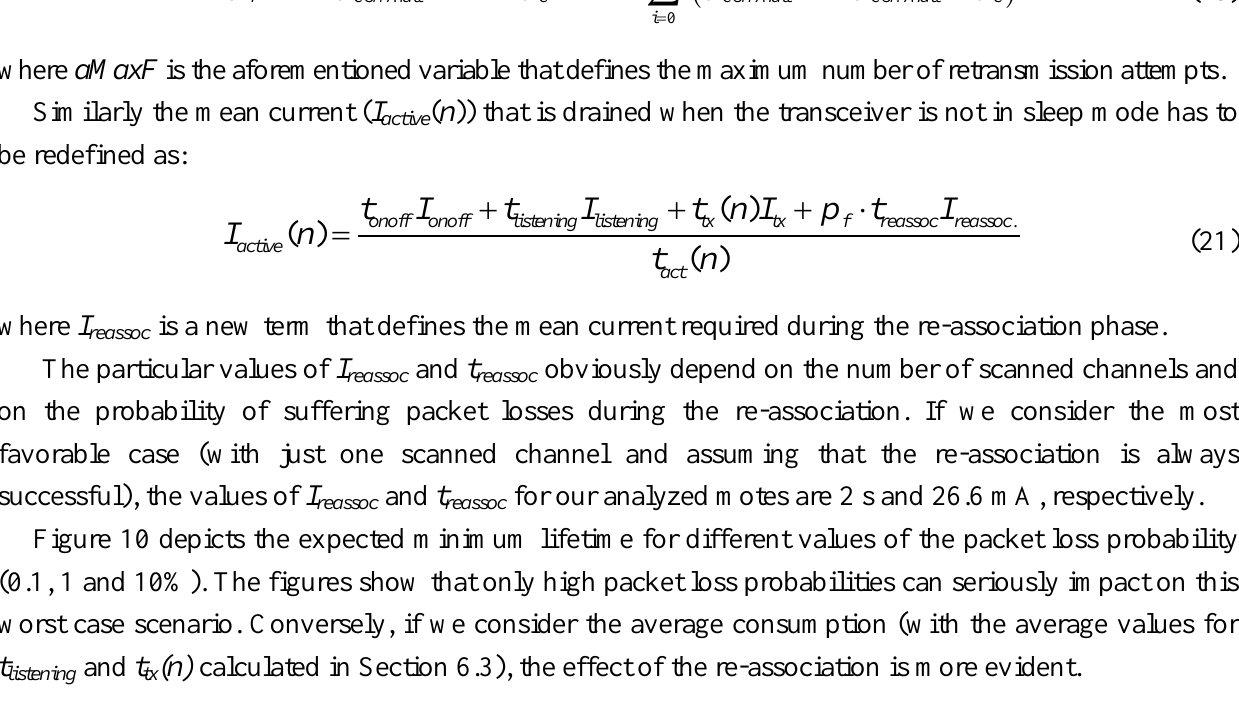
Figure 10. Effect of the re-association on the minimum predicted battery